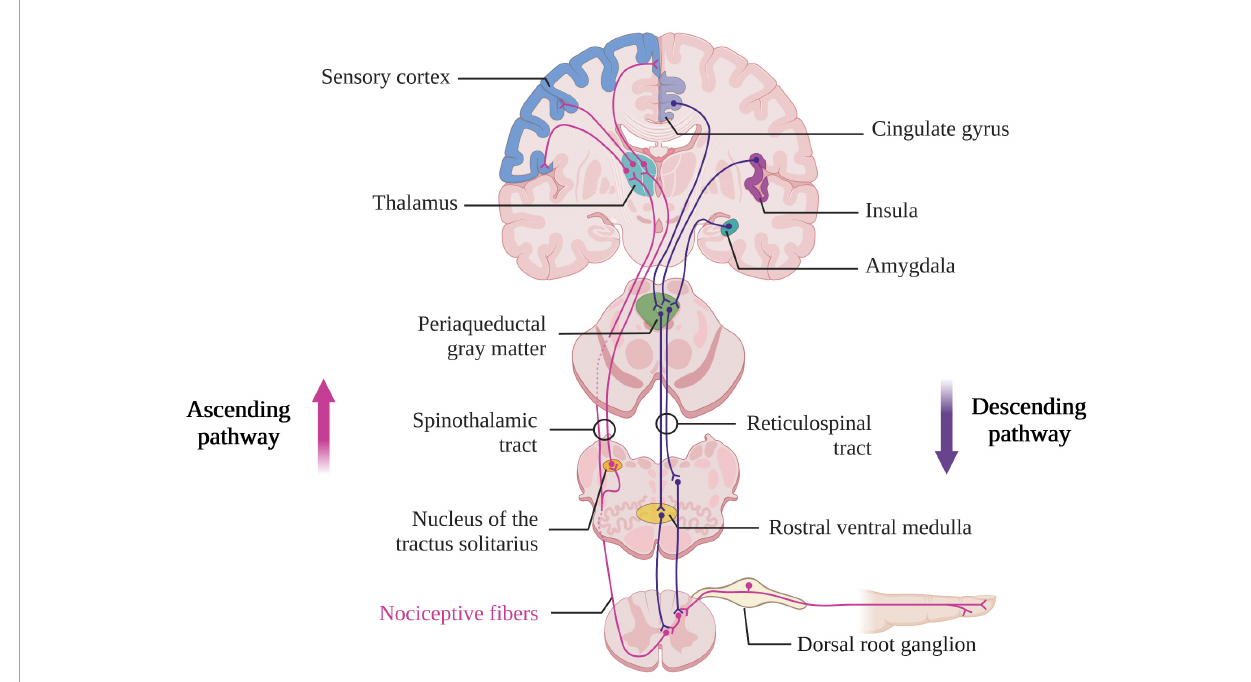
FIGURE2 Ascending and descending nociceptive pathways (created with BioRender.com). Based on Brown et al.